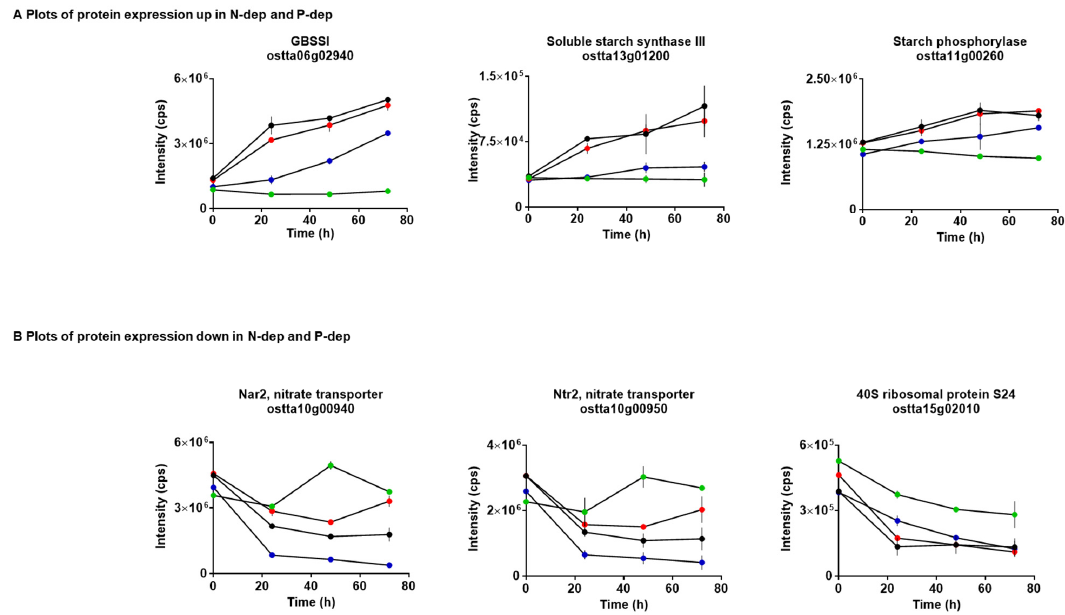
Figure 3. Differential expression of proteins in both N-dep and P-dep conditions. A number of proteins showed ( A ) increased and ( B ) decreased expression in response to the different nutrient-limiting conditions. Key: Complete media = green; N-dep = red; P-dep = blue; NP-dep = black.